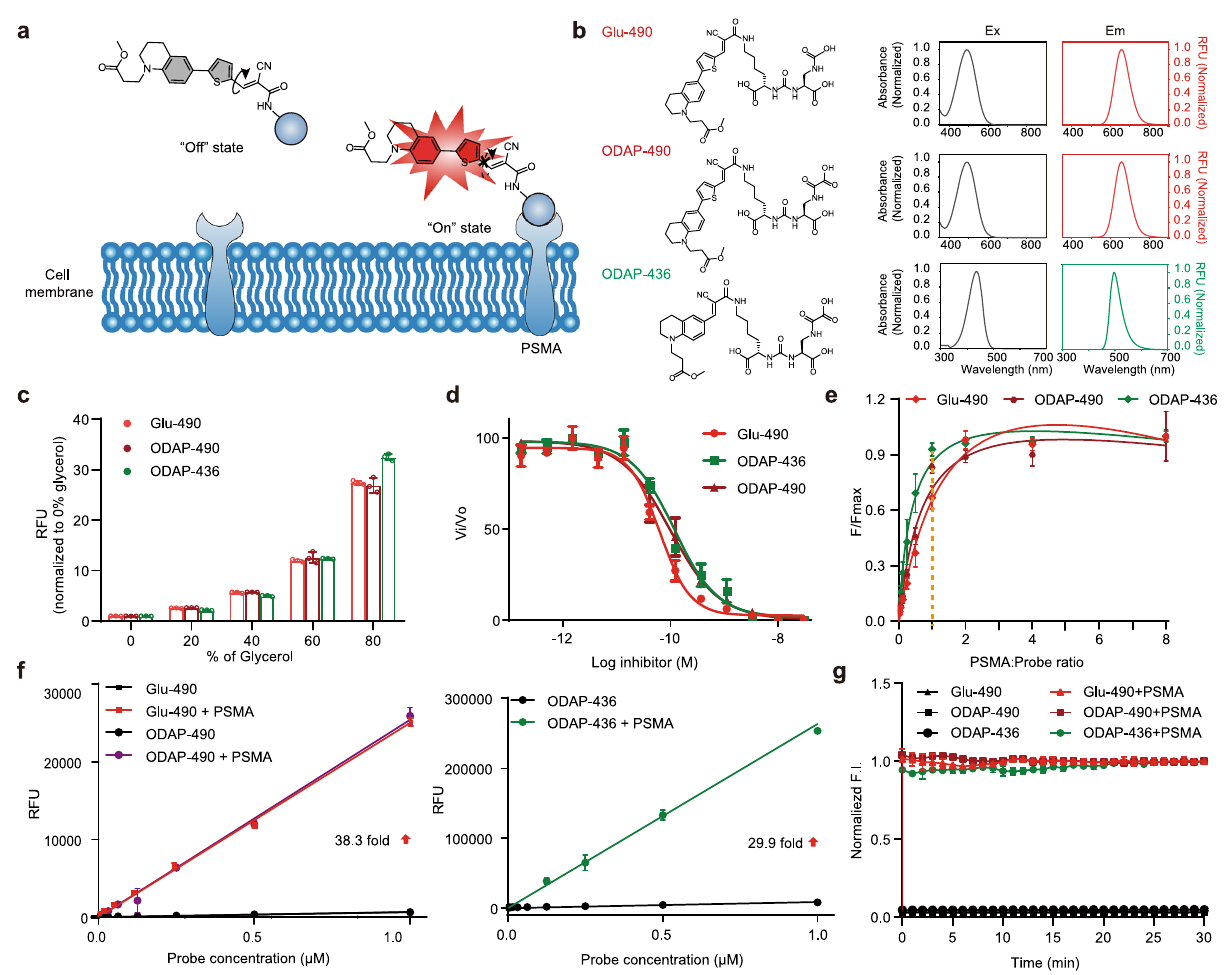
Fig. 1 Strategy, structures, and fl uorescence properties of the PSMA-activatable probes. a Schematic of probe binding and activation. b Structures, absorbance, and fl uorescence spectra of PSMA activated fl uorescent probes: Glu-490, ODAP-490, and ODAP-436. RFU relative fl uorescence units. c Changes in fl uorescence intensity of probes in solutions with increasing glycerol concentrations. Probe concentration was 0.1 mM and data were normalized to PBS control. Data are presented as mean values± s.d. ( n = 3 biologically independent experiments). d Inhibition of PSMA enzymatic activity using the radioenzymatic assay. Data are presented as mean values ± s.d. ( n = 2 biologically independent experiments). e Saturation binding of rhPSMA/ probe complexes. Data are presented as mean values ± s.d. ( n = 3 biologically independent experiments). f Fluorescence intensity of the rhPSMA/probe complex in response to concentration changes. Data are presented as mean values ± s.d. ( n = 3 biologically independent experiments). g Time frame for rhPSMA/probe complex formation. Data are presented as mean values ± s.d. ( n = 3 biologically independent experiments). F.I. fl uorescence